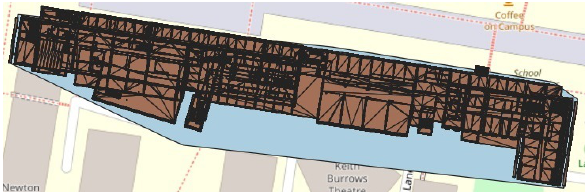
Figure 3. Geo-referenced IFC model of the Red Centre. BIM model on top of the blue convex hull of the OSM feature used in the